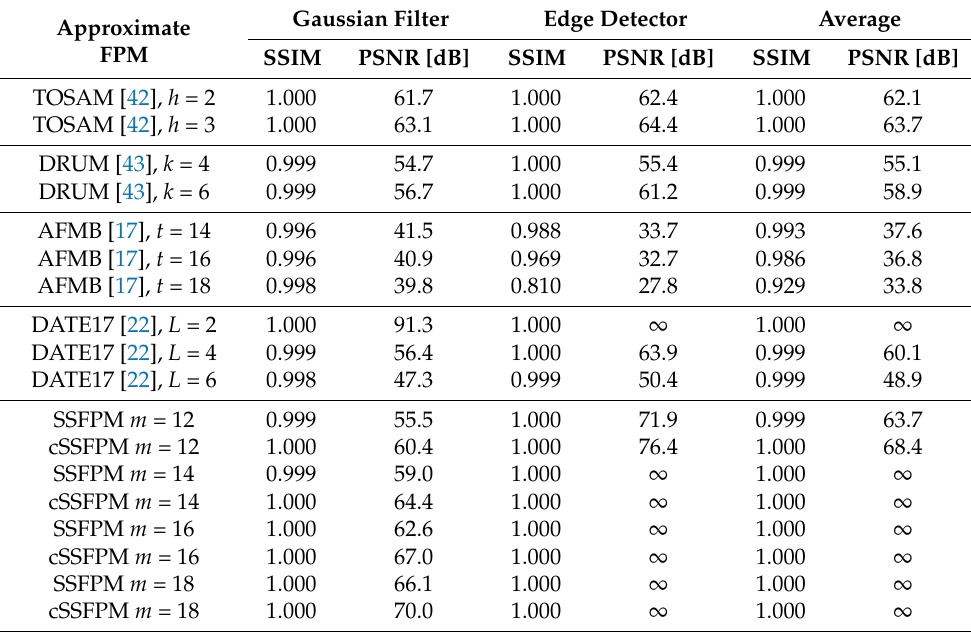
Table 4. Accuracy of the proposed segmented FPMs and of the state-of-the-art in image filtering application.